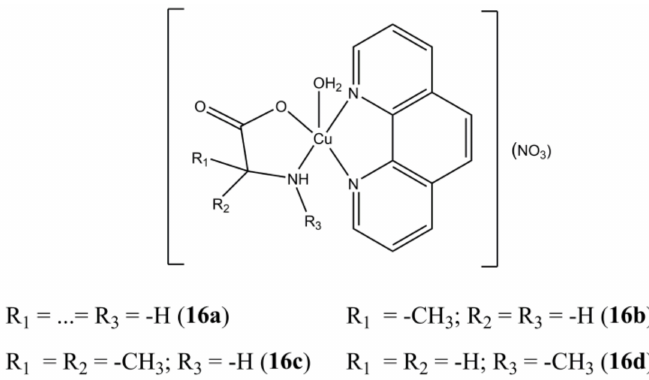
Figure 16. Structures of [Cu(phen)(AAn)(H 2 O)](NO 3 ) complexes.